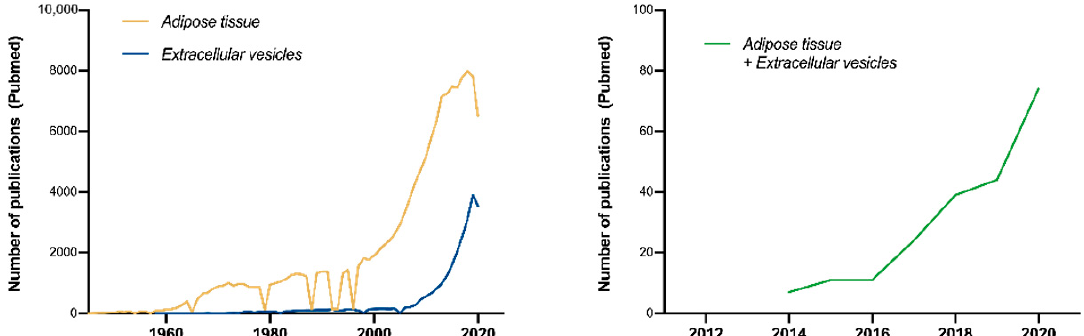
Figure 1. Timeline for “adipose tissue” and “extracellular vesicles” publications. Lines show the number of publications per year corresponding to the keywords “adipose tissue” (dark yellow, left panel), “extracellular vesicles” (blue, left panel), or a combination of both (green, right panel) in the PubMed database (https://www.ncbi.nlm.nih.gov/pubmed, accessed on 31 December 2020). Note that both terms follow a similar trend. The slight decrease in the number of publications in 2020 for both individual topics may be due to the pandemic situation caused by SARS ‐ CoV ‐ 2 infections [20,21] .